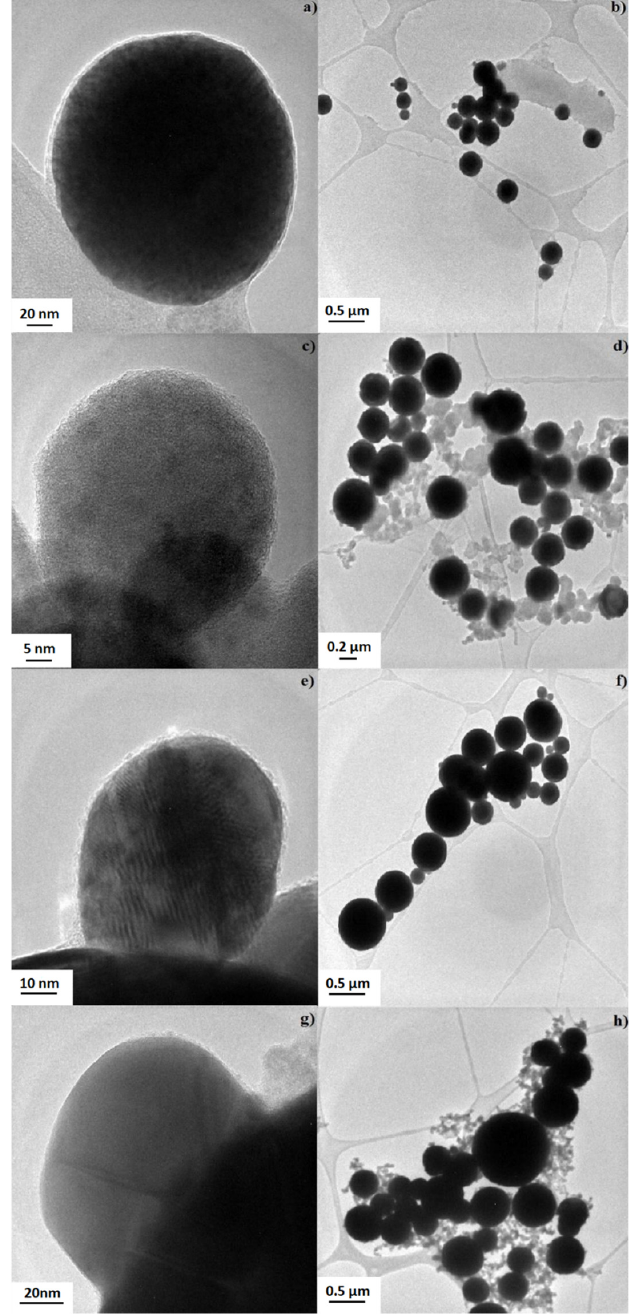
Figure 8. TEM images of AgCu nanosized particles, ( a , b ) 0.05 mol/L ( c , d ) 0.1 mol/L ( e , f ) 0.2 mol/L and ( g , h ) 0.4 mol/L.